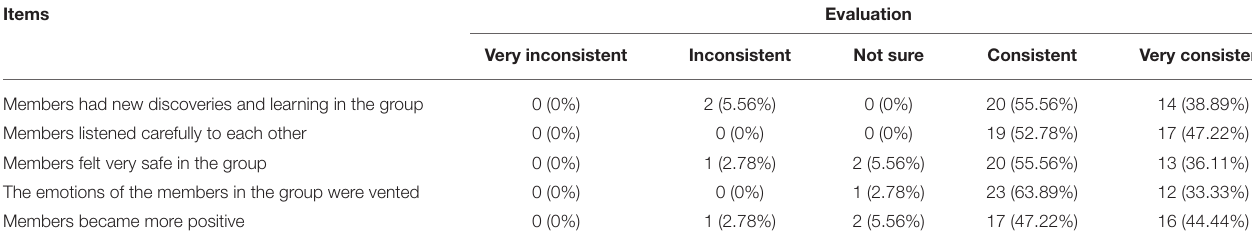
TABLE 6 | Effectiveness evaluation of leaders on OESAG ( N =